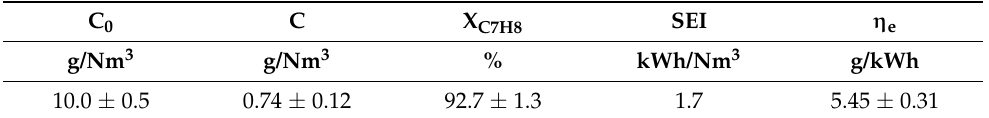
Table 2. Parameters of toluene conversion in MW plasma.